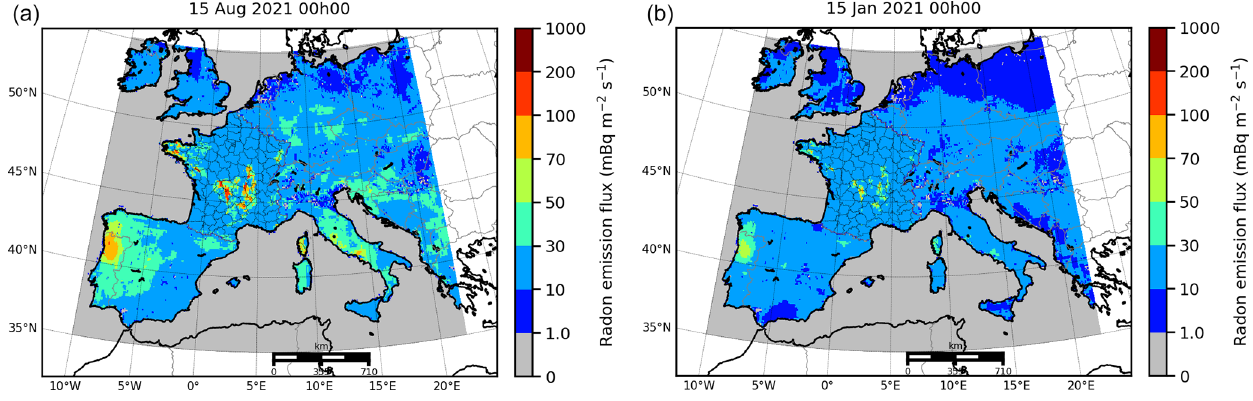
Figure 1. Radon-222 exhalation maps. (a) Exhalation in August. (b) Exhalation in January.